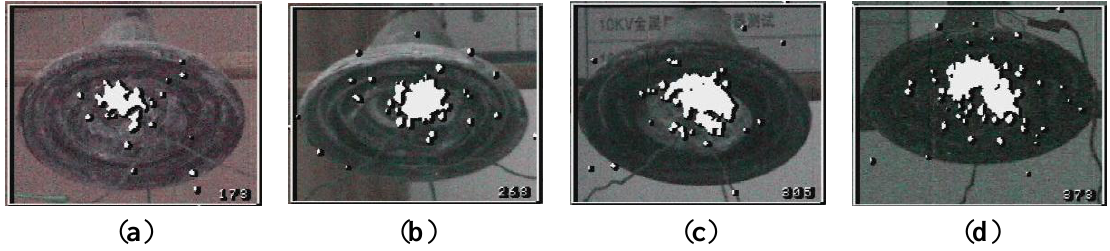
Figure 10. Ultraviolet images of polluted insulators at 85% RH; ( a ) Insulator of